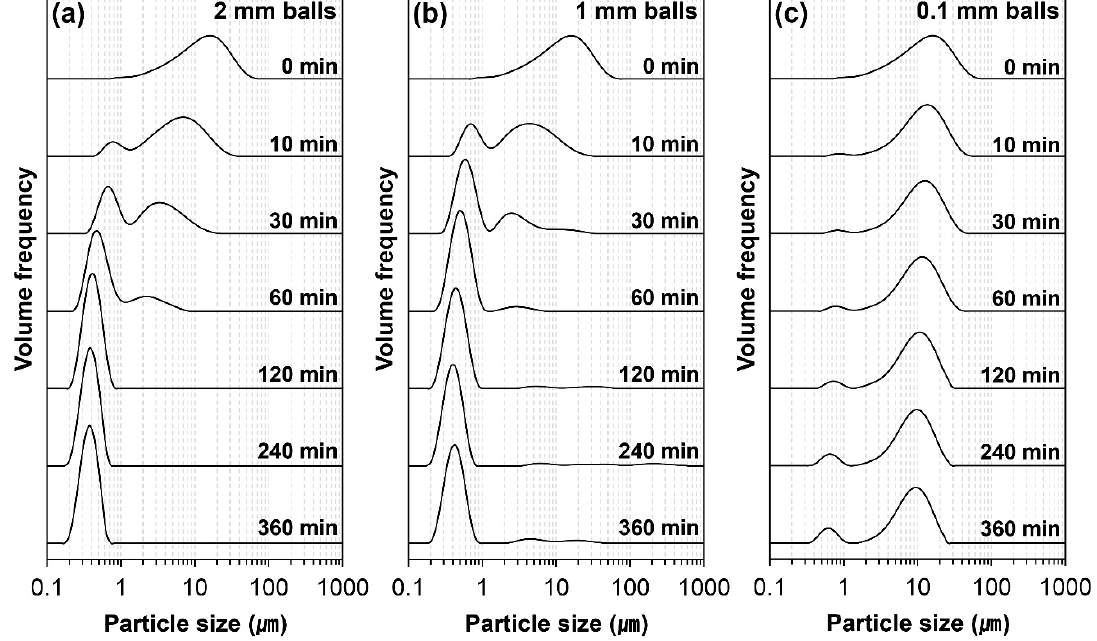
Figure 6. Changes in particle size of talc upon grinding, measured using laser di ff raction particle size analysis. The ball size for high-energy ball milling is ( a ) 2 mm, ( b ) 1 mm, and ( c ) 0.1 mm.